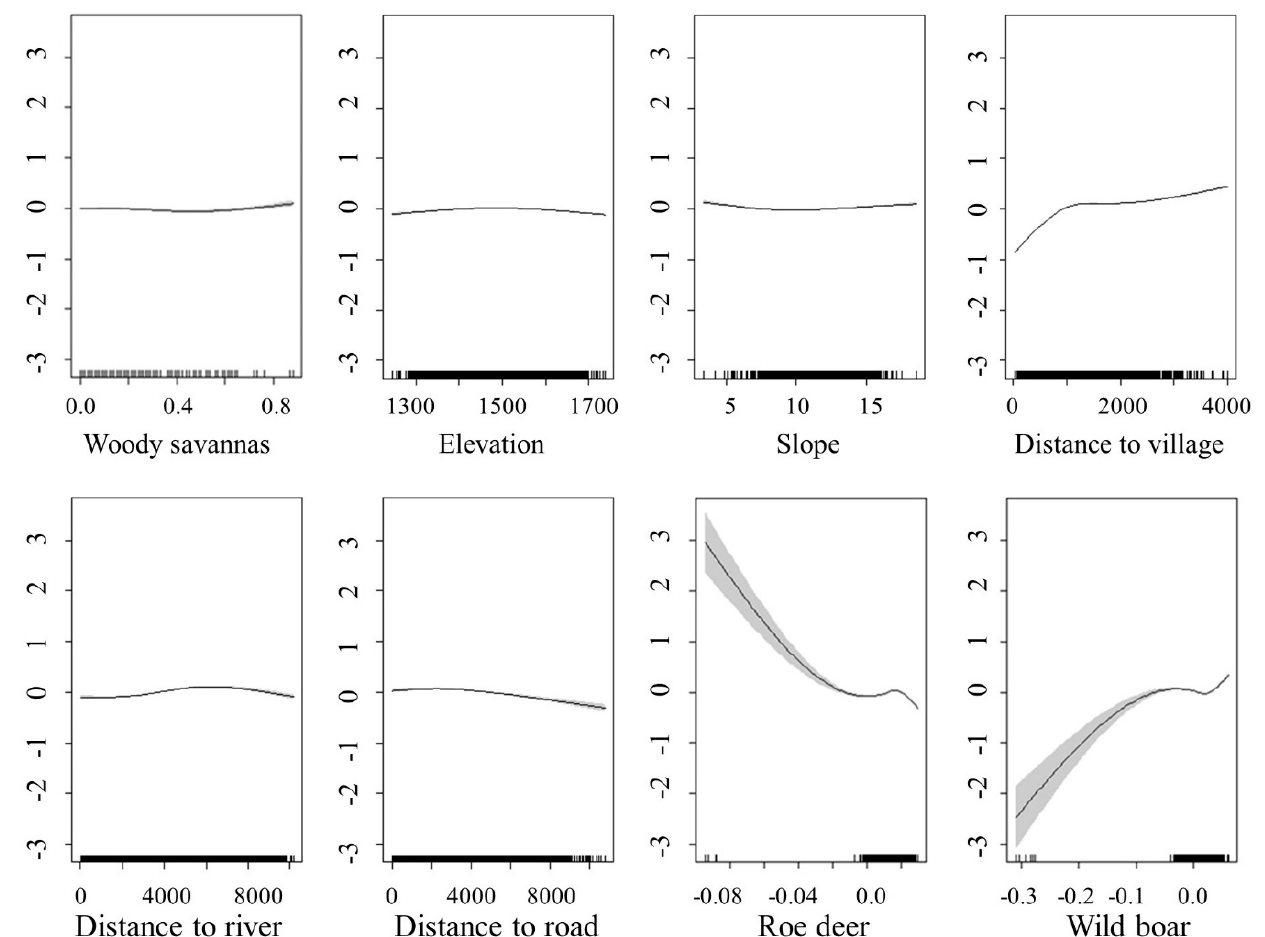
Figure 4. Relationships between the North China leopard density (individuals/0.25 km 2 ) and two kinds of prey and envi- ronmental factors by generalized additive model (GAM). The ordinate shows the estimated population density of North China leopards (individuals/0.25 km 2 ), and the abscissa shows the relative abundance of prey, and environmental and human factors.